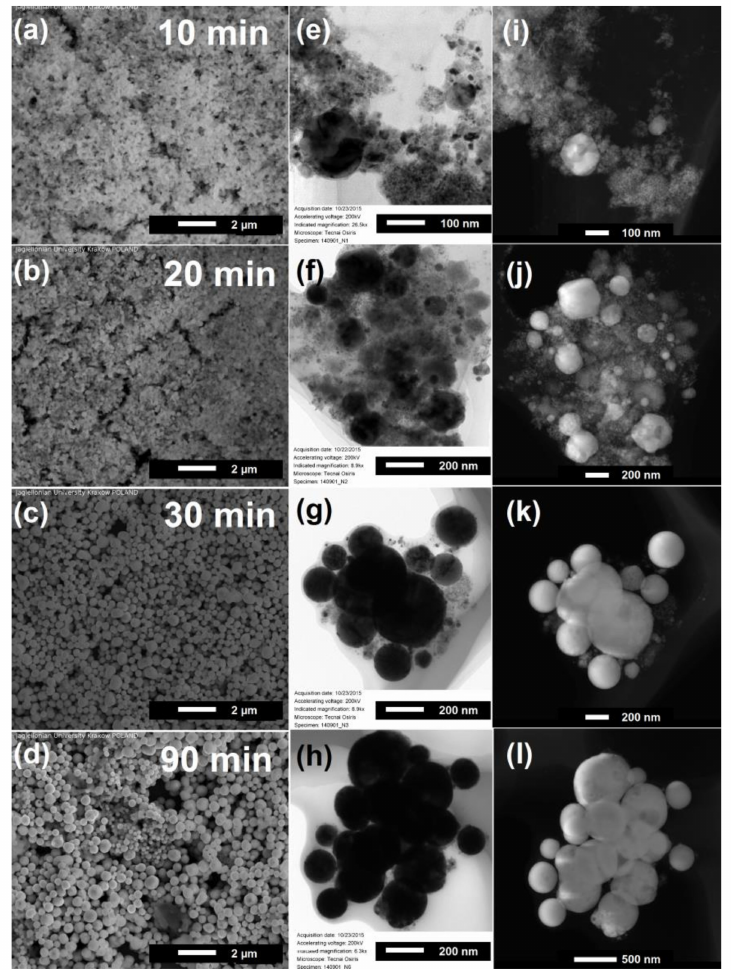
Figure 2. Electron microscopy images of particles prepared by pulsed laser irradiation (532 nm, 130 mJ/pulse · cm 2 ) of NiO nanoparticles irradiated ( a ) 10 min; ( b ) 20 min; ( c ) 30 min; ( d ) 90 min: SEM SE ( a – d ); TEM (transmission electron microscope) ( e – h ); and STEM-HAADF (High angle annular dark field scanning transmission electron microscopy ) ( i – l